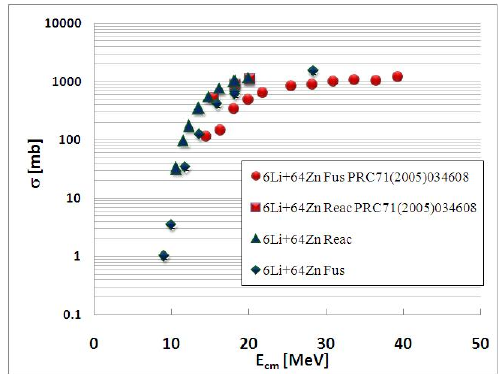
Fig. 3. Present total reaction cross-section (blue triangles) and total fusion cross-section (blue diamonds) are compared with the total reaction cross-section (red squares) and total fusion cross- section (red dots) measured in